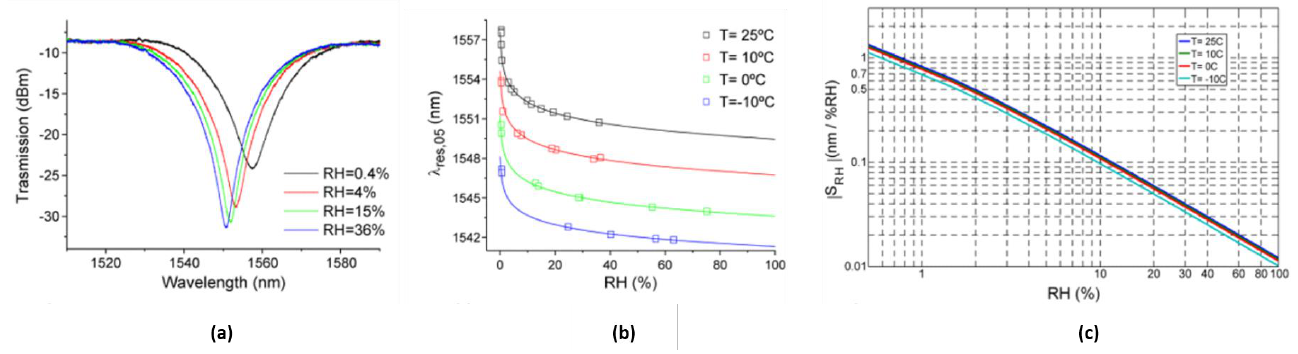
Figure 19. ( a ) Typical spectral RH response of TiO 2 -coated LPG at 25 °C. ( b ) RH characterization and ( c ) RH sensitivity at different temperatures (from Ref. [125]).